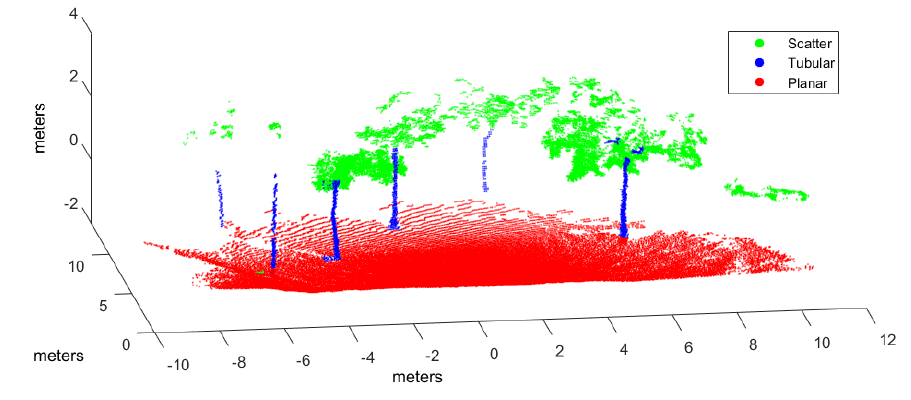
Figure 5. Hand labeled Garden point